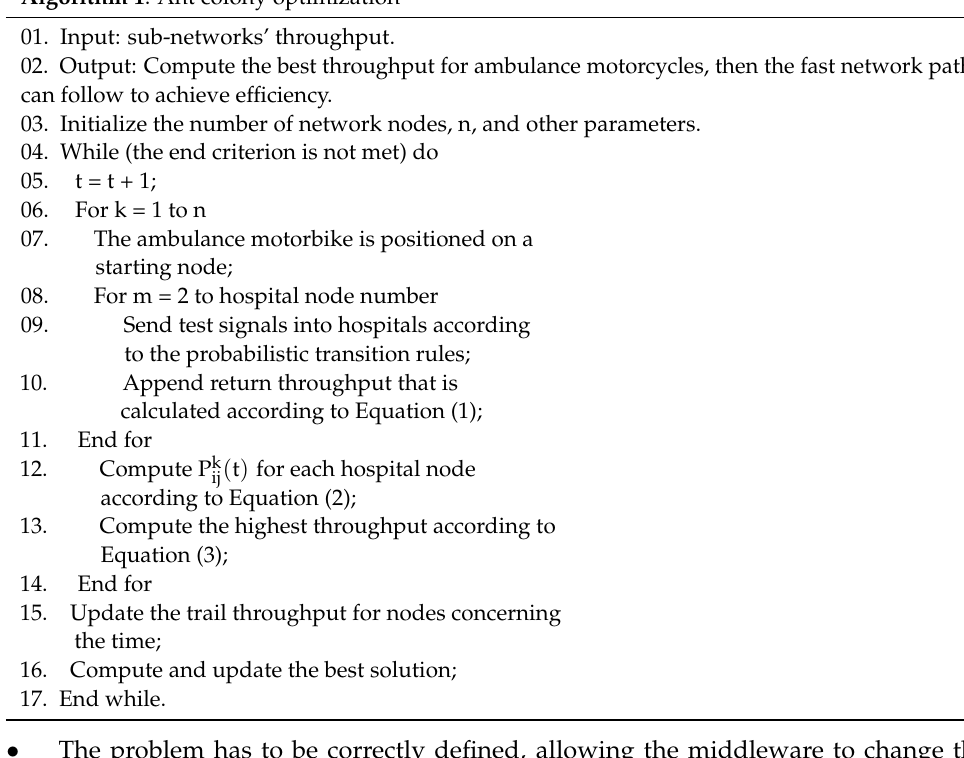
Algorithm 1 . Ant colony